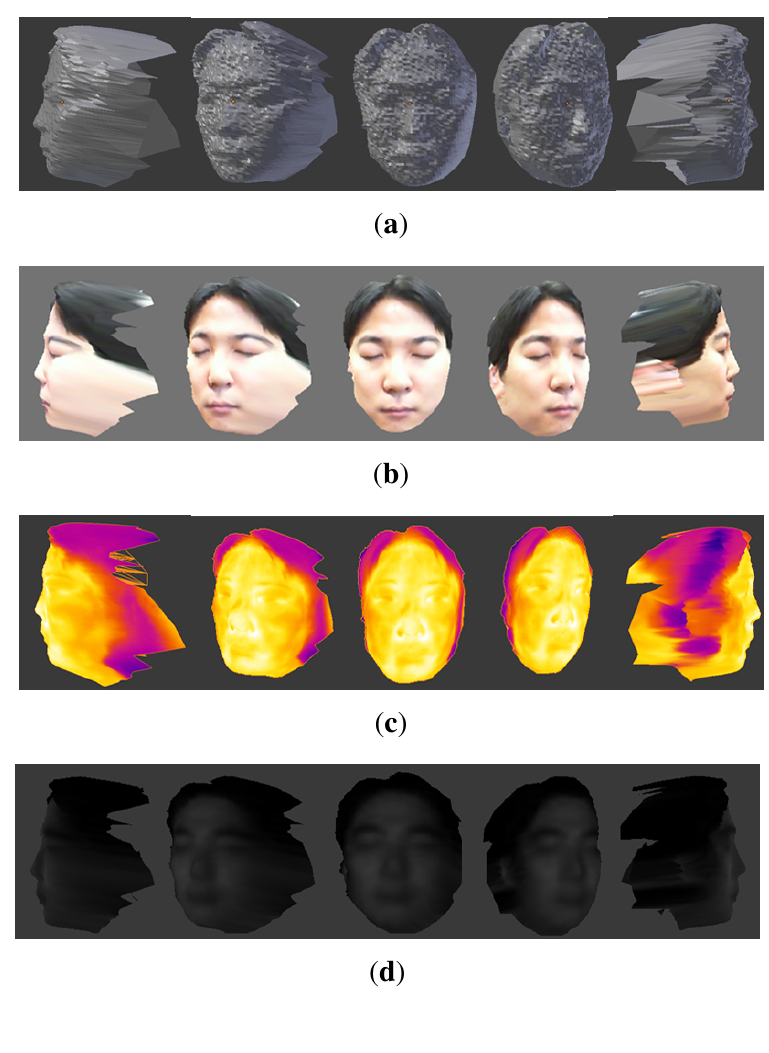
Figure 10. 3D multi-spectrum face data: ( a ) 3D face shape data from the ToF camera; ( b ) color 3D multi-spectrum data; ( c ) thermal-IR 3D multi-spectrum data; and ( d ) near-IR 3D multi-spectrum